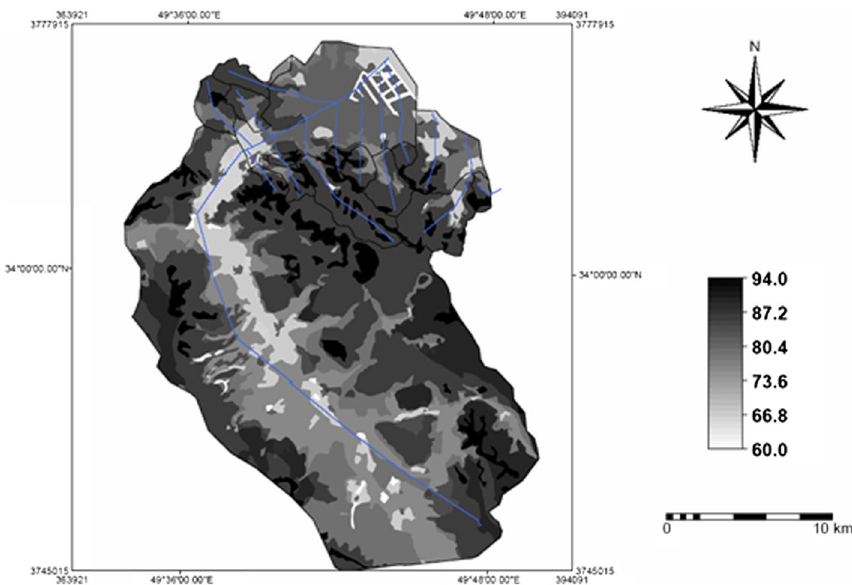
Fig. 2 CN layer and its values in the watersheds overlooking the Arak